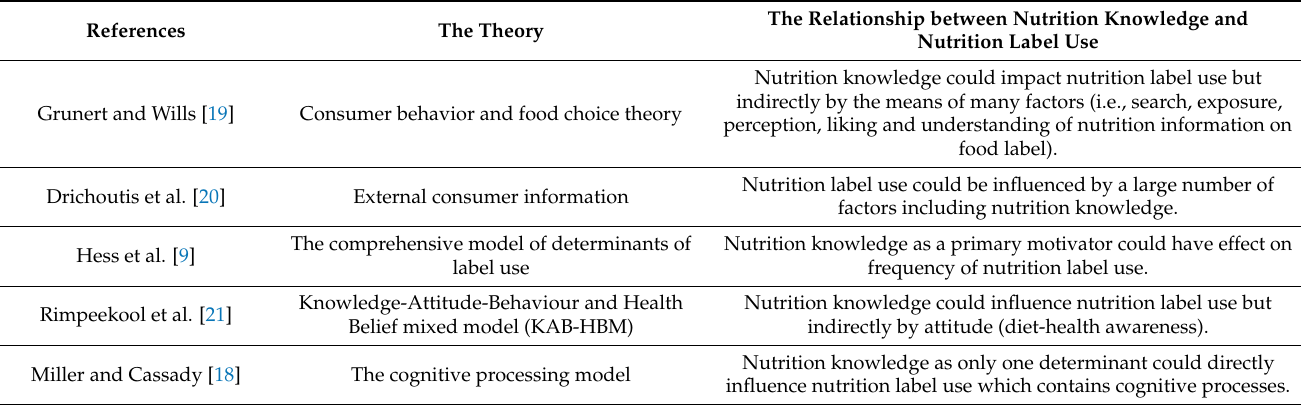
Table 1. Overview of the theories conceptualizing the relationship between nutrition knowledge and nutrition label